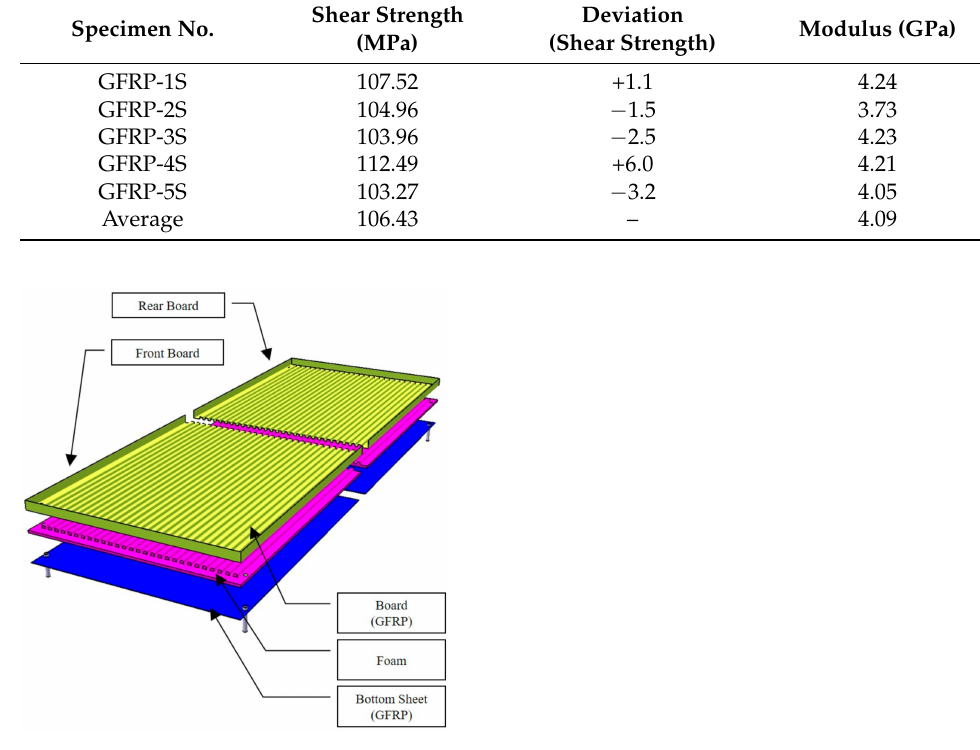
Figure 7. Applied material of floor structure.